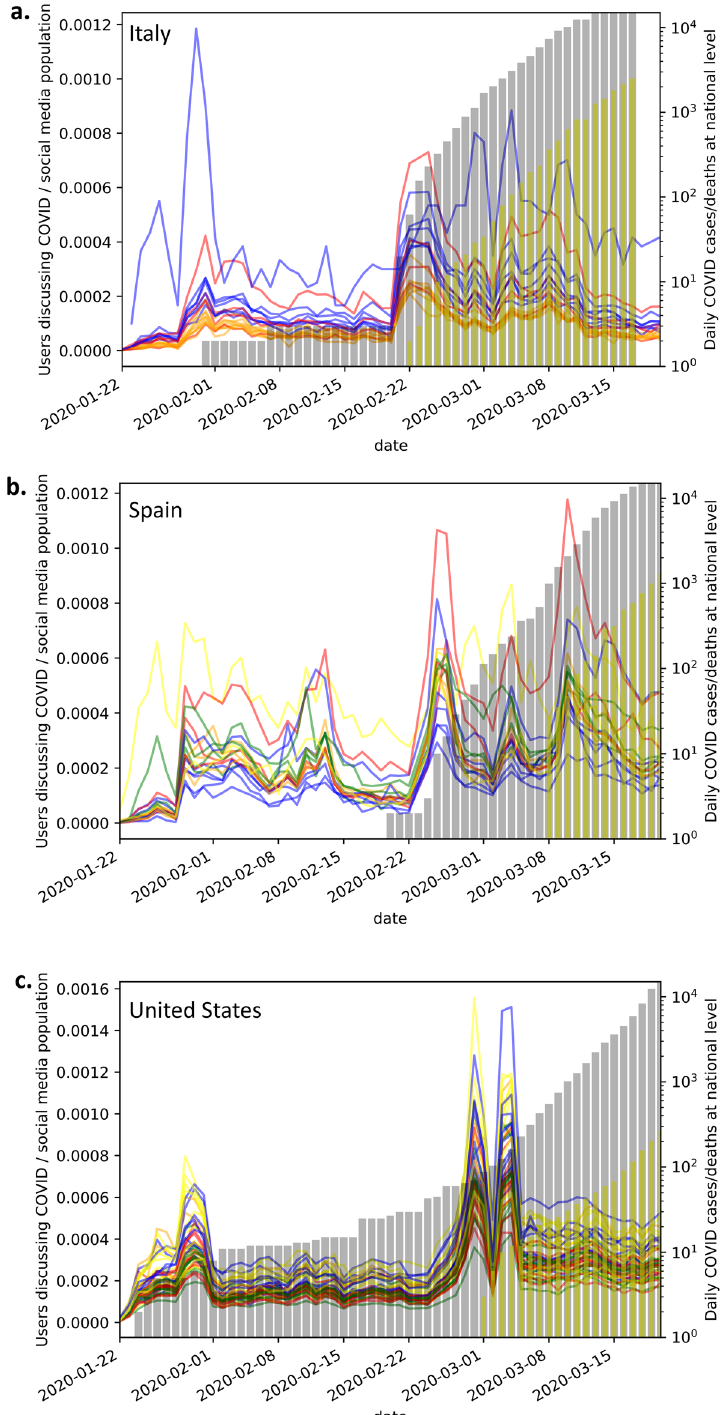
Figure 1. Plots of COVID-19 related Twitter activity superimposed to number of confirmed COVID-19 cases and cumulative number of deaths nationwide. Twitters are geolocated and aggregated by geopolitical regions for ( a ) Italy; ( b ) Spain and ( c ) United States. For each country we group and color code regions by geolocation in the following way: ( a ) Italy: Northern regions (blue), Central regions (red) and Southern regions (orange), ( b ) Spain: Northeastern regions (blue), Northwestern regions (green), Central regions (red), Southern regions (orange), Autonomous cities (yellow), ( c ) United States: Northeastern states (blue), Southeastern states (green), Midwestern states (red), Southwestern states (orange), Western states (yellow). The growth of confirmed COVID-19 cases nationwide (cumulative) is represented by grey bars while the cumulative number of COVID- 19 deaths nationwide is represented by yellow